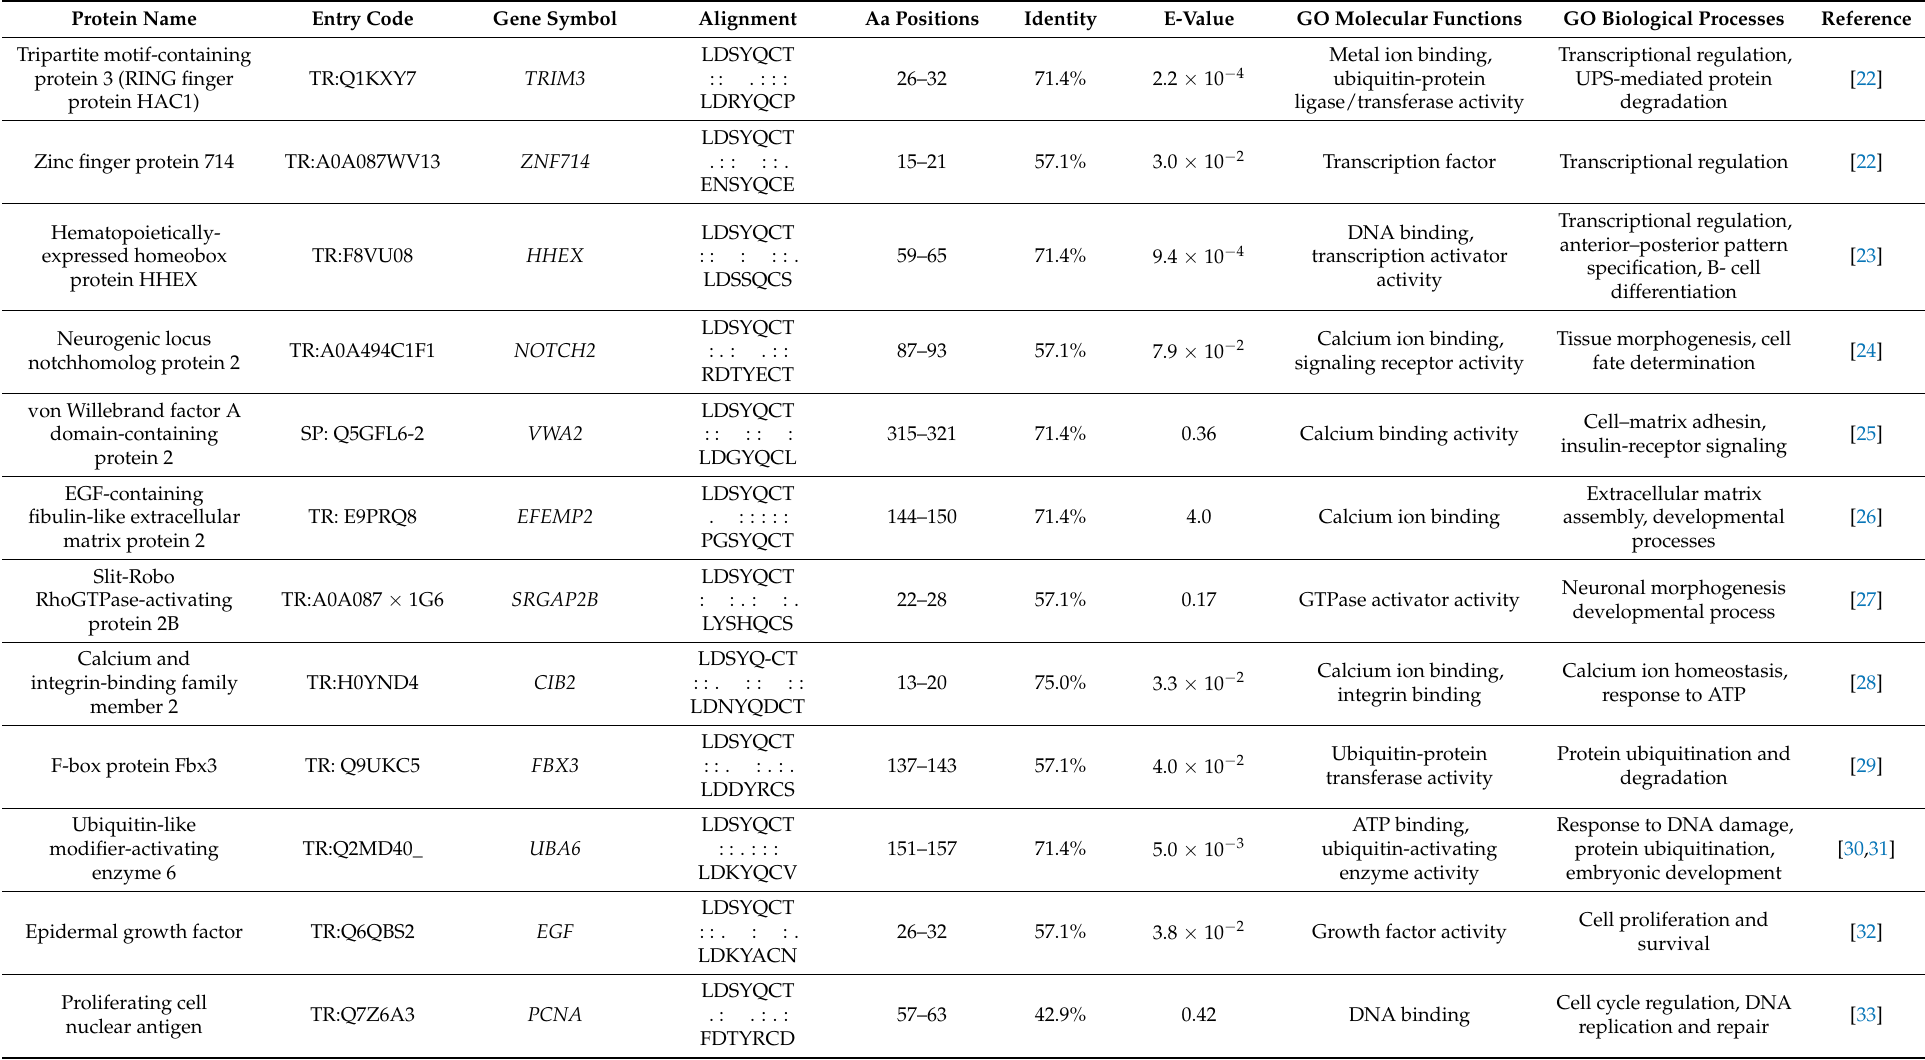
Table 1. Selected human proteins retrieved from UniprotKB knowledgebase containing AFP 14–20 -like